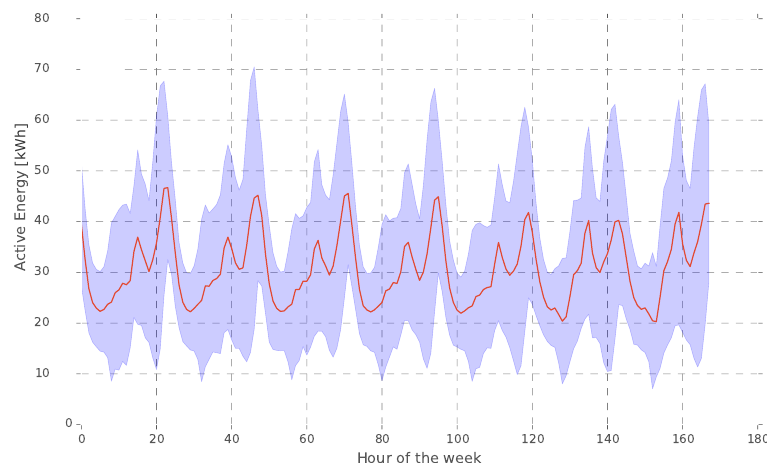
Figure 5. Average load grouped by hour of the week (Network 1). For this plot, weeks begin on Monday and end on Sunday. The shadowed area represents two times the standard